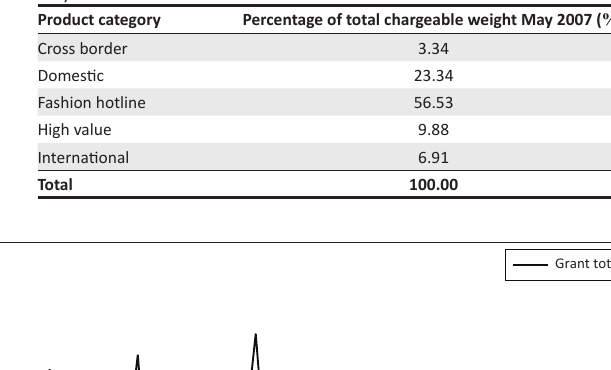
TABLE 2: Contribution of each product category to total chargeable weight – May 2007.